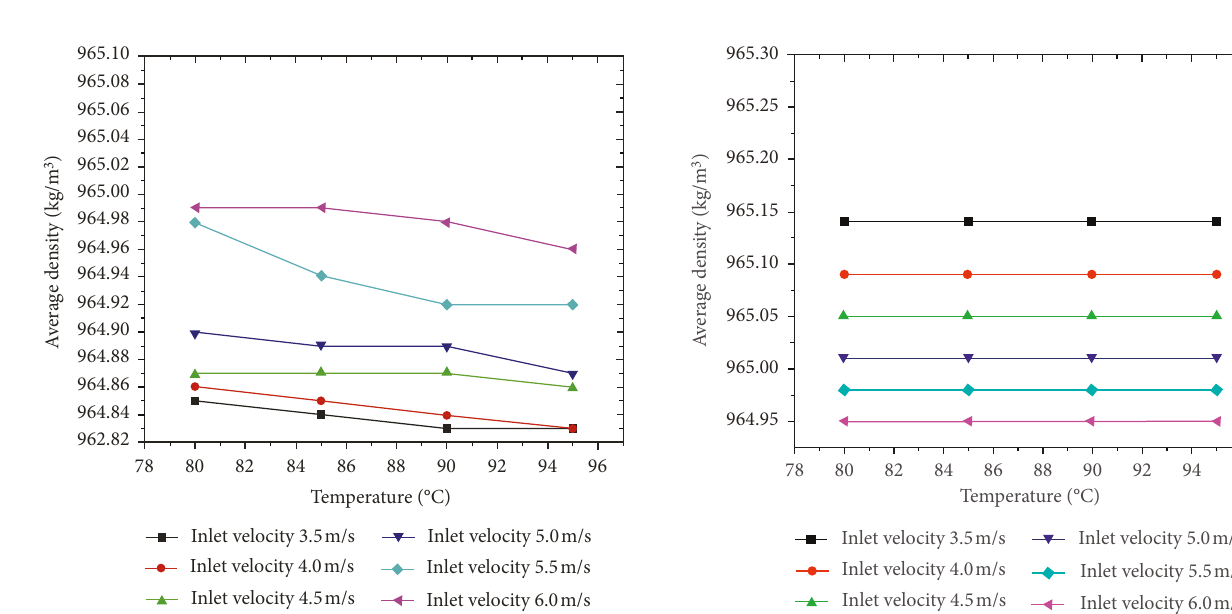
Figure 39: Inlet velocity and average density with temperature for 100%